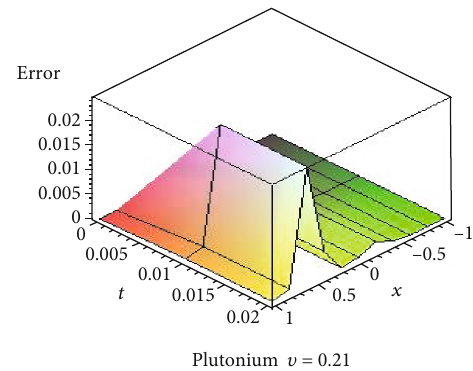
Figure 13: The value absolute error by PNM at N = 20 and T = 0 : 02 .